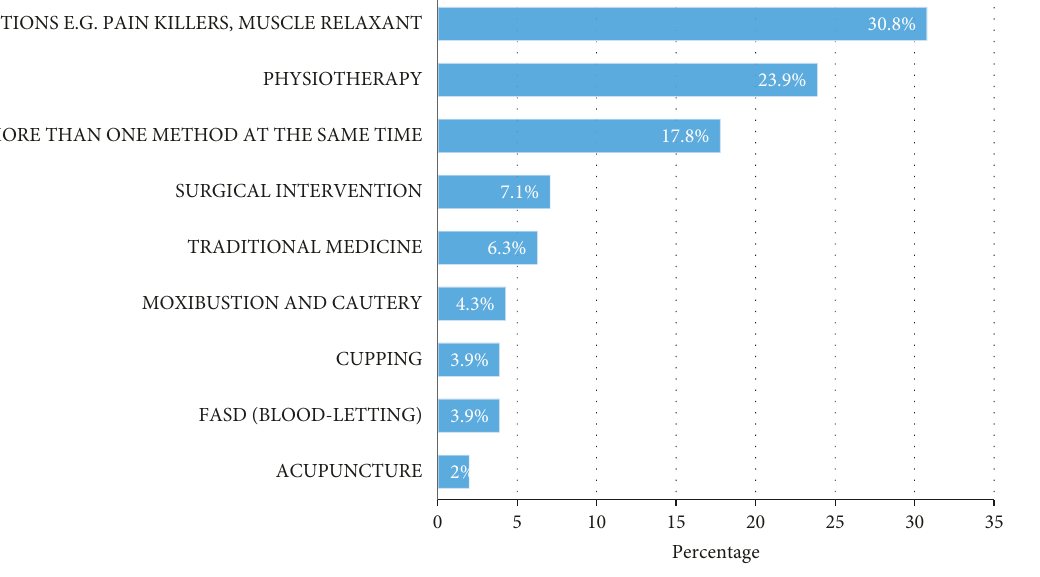
Figure 2: Self-treatment of